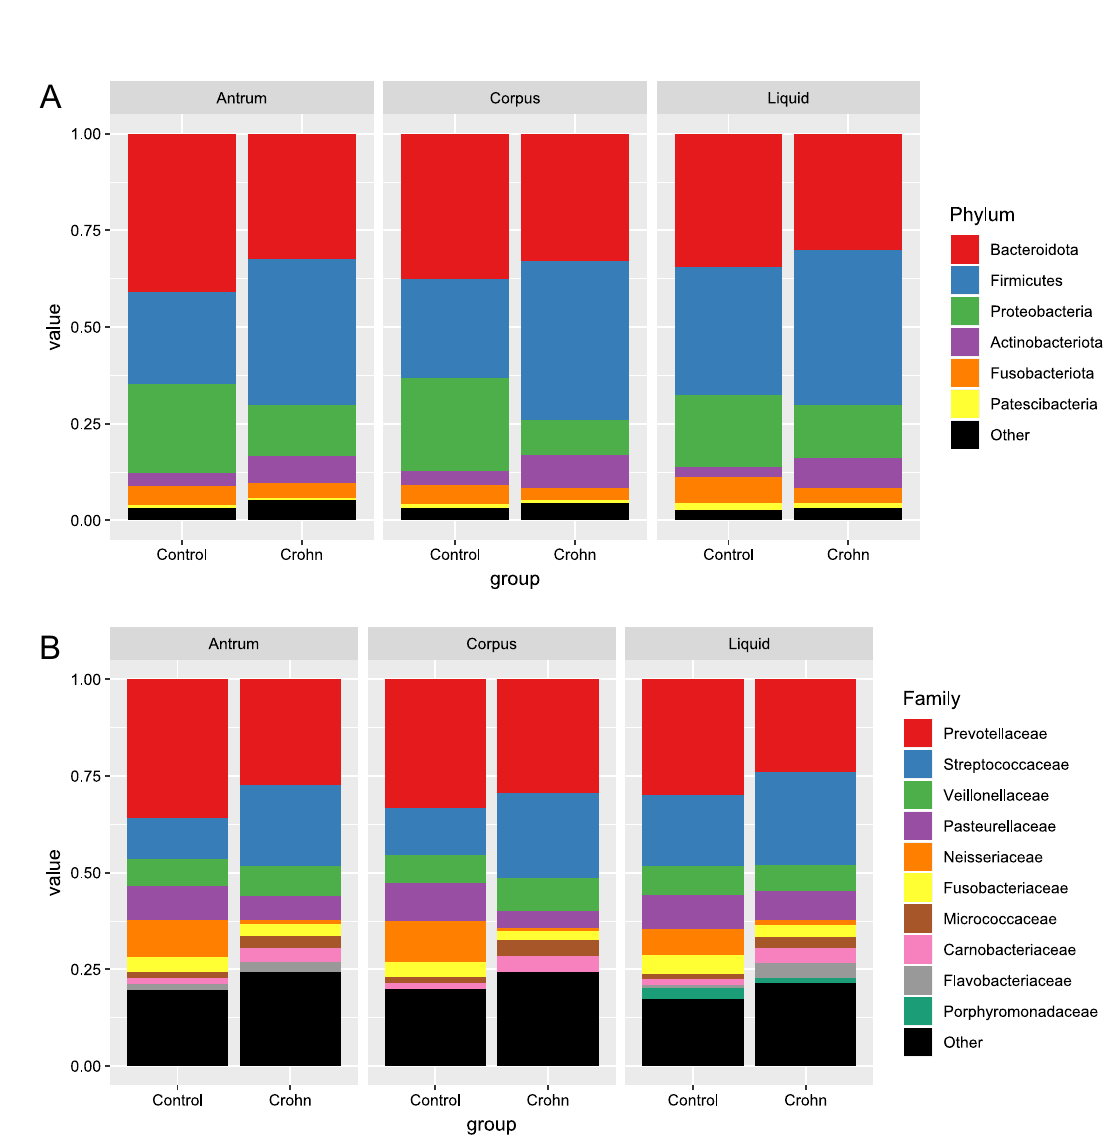
Figure 3. Mean taxa abundances on phylum ( A ) and family ( B ) levels. Only taxa with mean abundance higher than 0.02 (families) or 0.01 (phyla) are